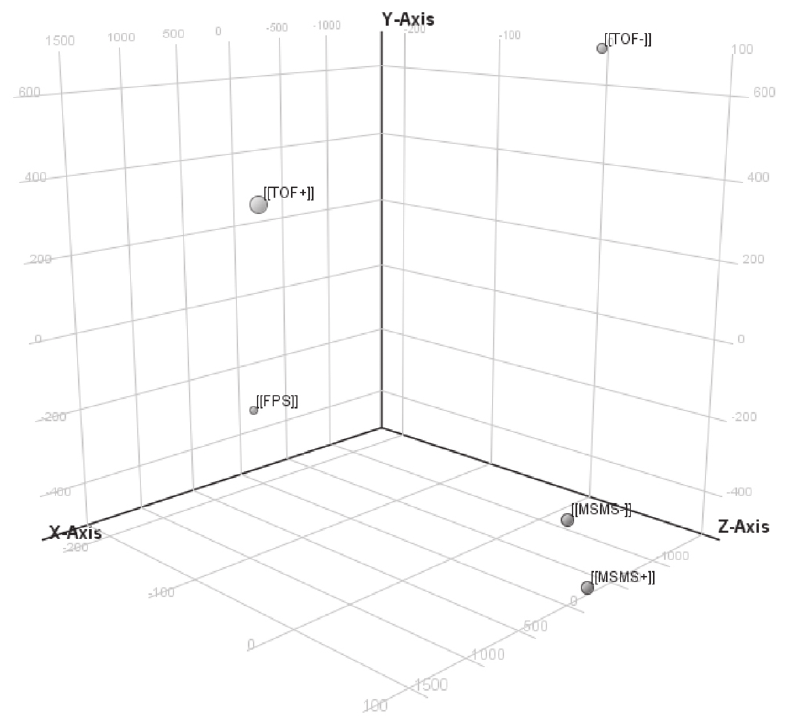
Figure 4: Comparison of the data acquisition methods by PCA (for FPS the summary data of both polarizations was